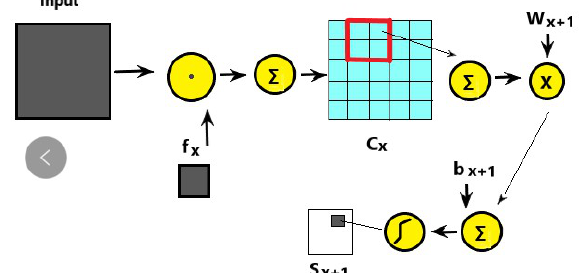
Figure 3. The detailed process of convolution and